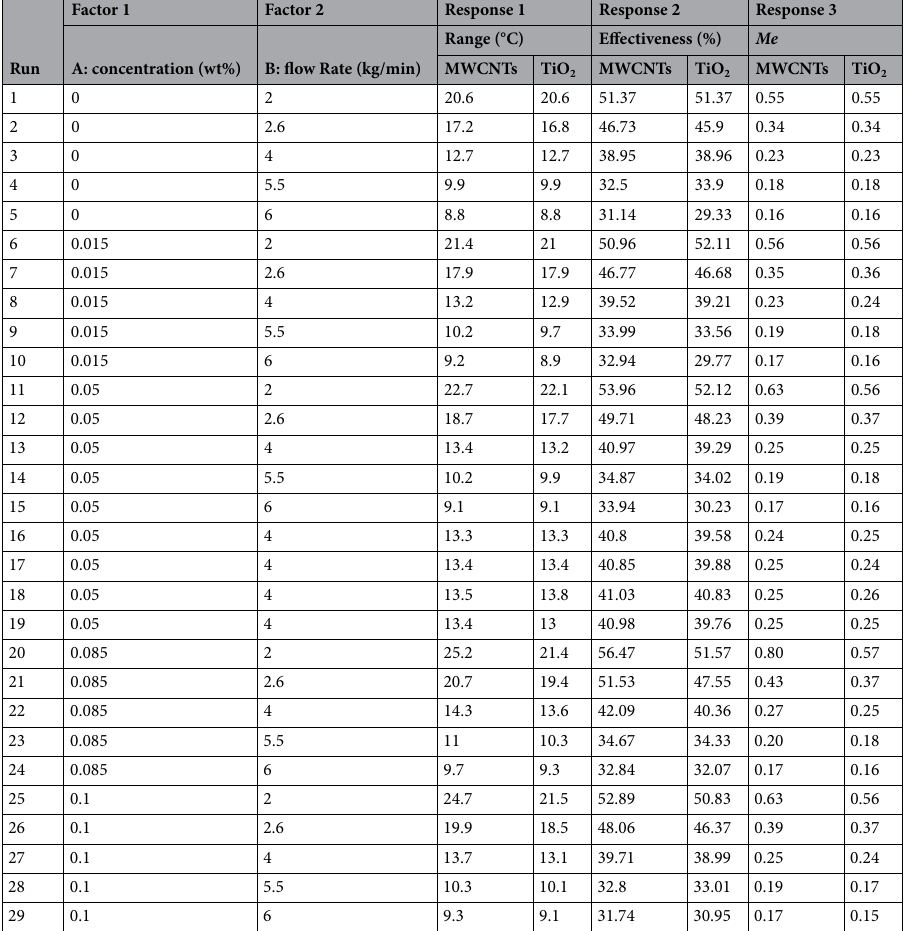
Table 6. The design of experiment table for MWCNTs and TiO 2 nanofluids by the CCD-based RSM method.